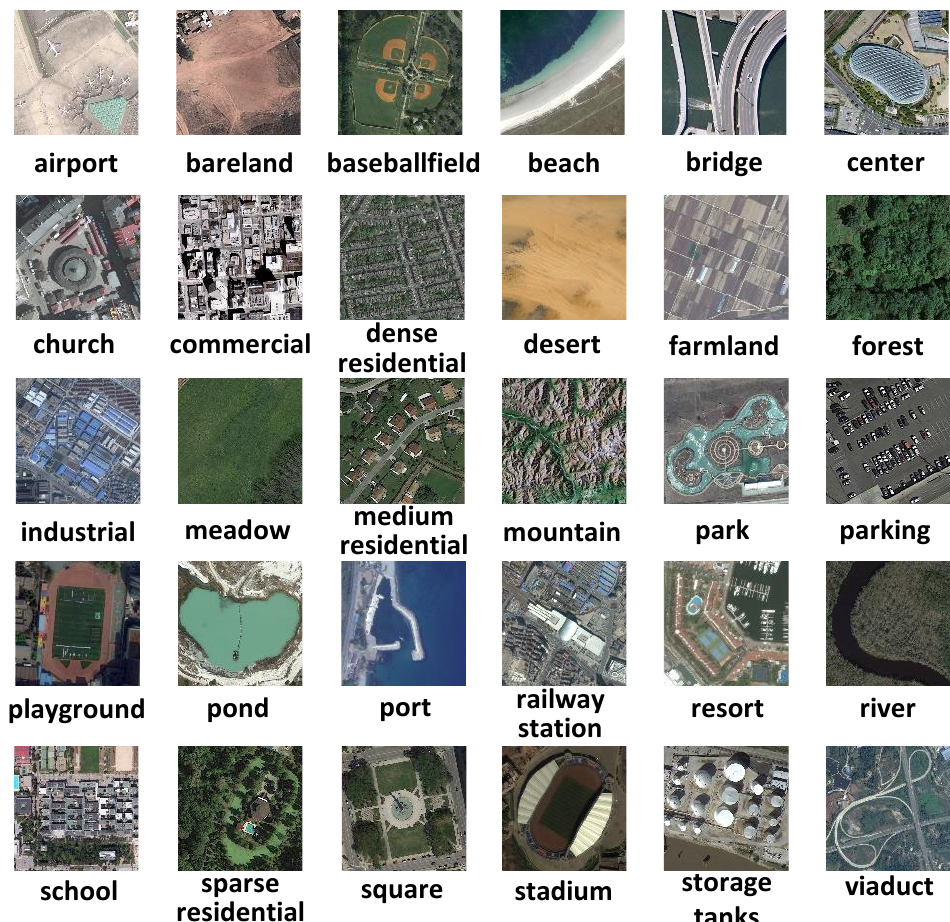
Figure 9. Examples of different categories in the AID